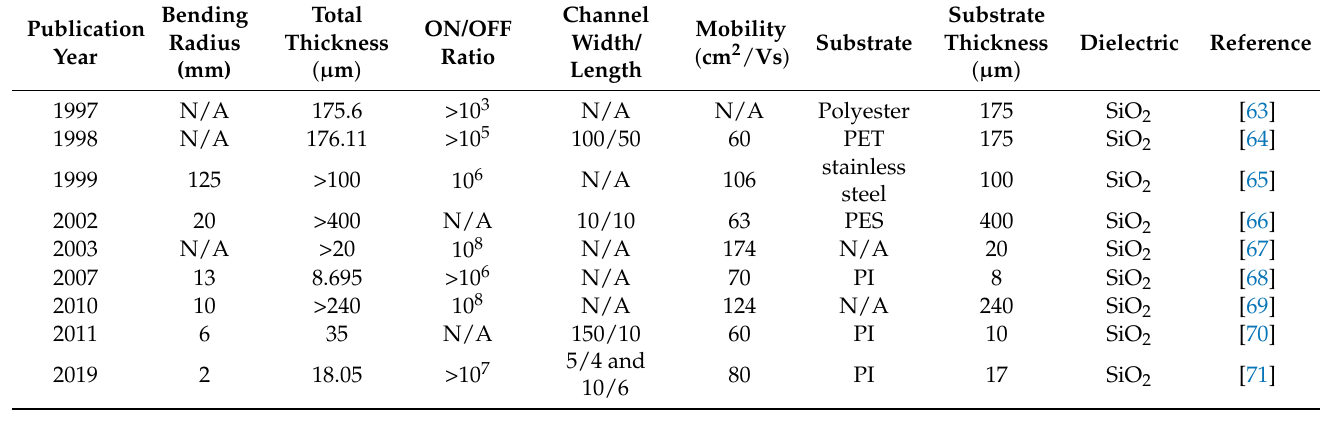
Figure 5. The progress of LTPS TFTs with ( a ) the total thickness and ( b ) the bending radius. Table 2. The detailed properties of the LTPS TFTs in Figure 5.